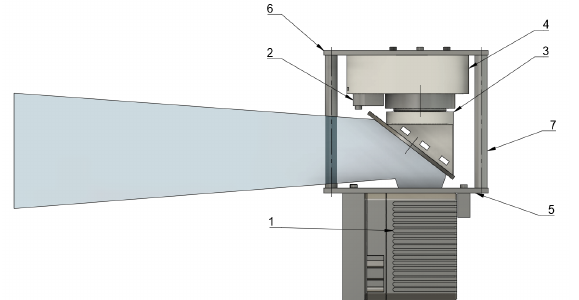
Figure 5. Mechanical design of mirror drive: (1) Livox Mid–40 lidar, (2) contactless encoder, (3) mirror support, (4) motor housing, (6) top plate, (5) bottom plate, (7) pillars. The resulting field of view is shown in blue. The system can be mounted in any position.